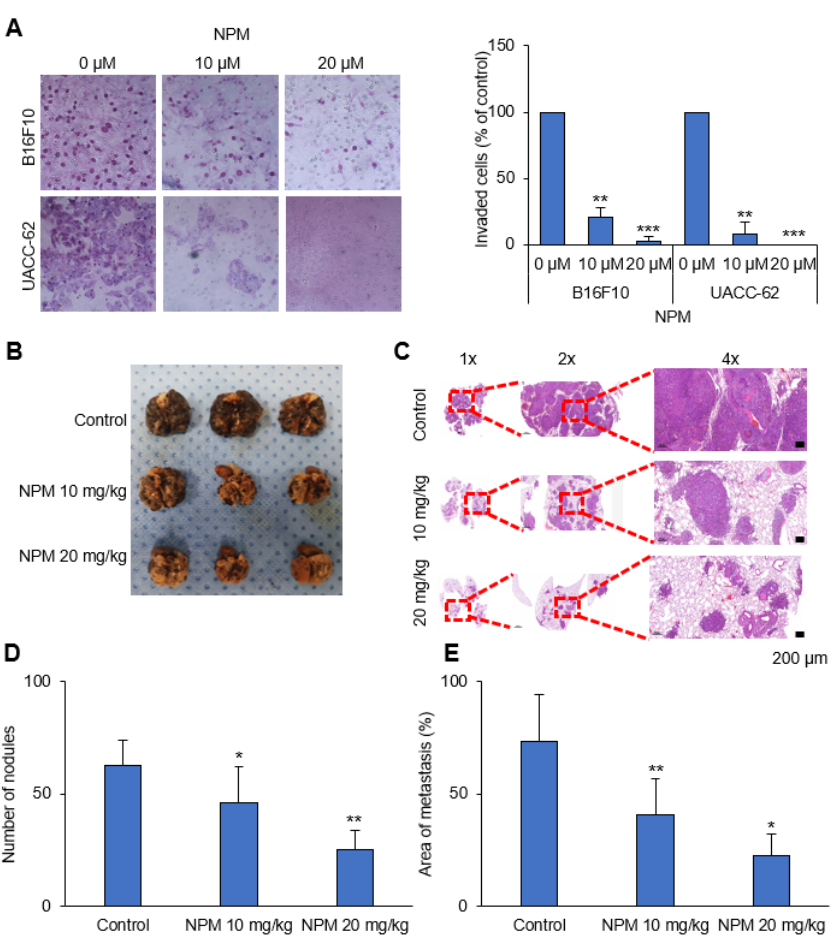
Figure 5. NPM reduces lung metastasis of B16F10 melanoma cells in immunocompetent mice. ( A ) Invasion assay performed with B16F10 and UACC-62 cell lines following NPM treatment for 16 h. Representative images of the invasion assay using B16F10 and UACC-62 cells (left). The numbers of invasive B16F10 and UACC-62 cells were measured using ImageJ (right). ( B ) Representative photographs of formalin-fixed lungs. ( C ) Metastatic lesions were observed with hematoxylin and eosin (H&E) staining. ( D ) Statistical analysis of the number of metastatic nodules. ( E ) Statistical analysis of the total metastatic area using ImageJ. Data represent the mean and standard deviation of three independent experiments. * p < 0.05, ** p < 0.01, and *** p < 0.001 compared with the vehicle control.